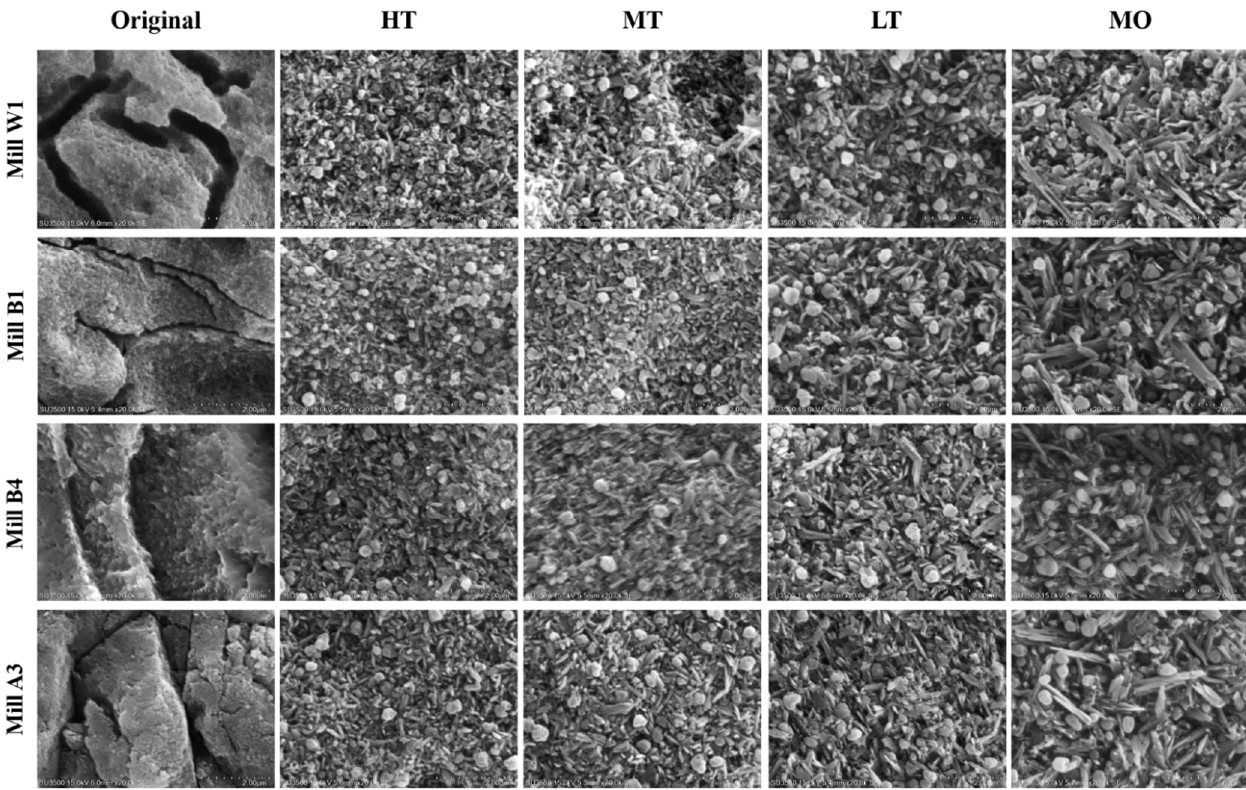
Figure 6. SEM images showing the microstructure of the e.max CAD ceramics in four different translucency extents.